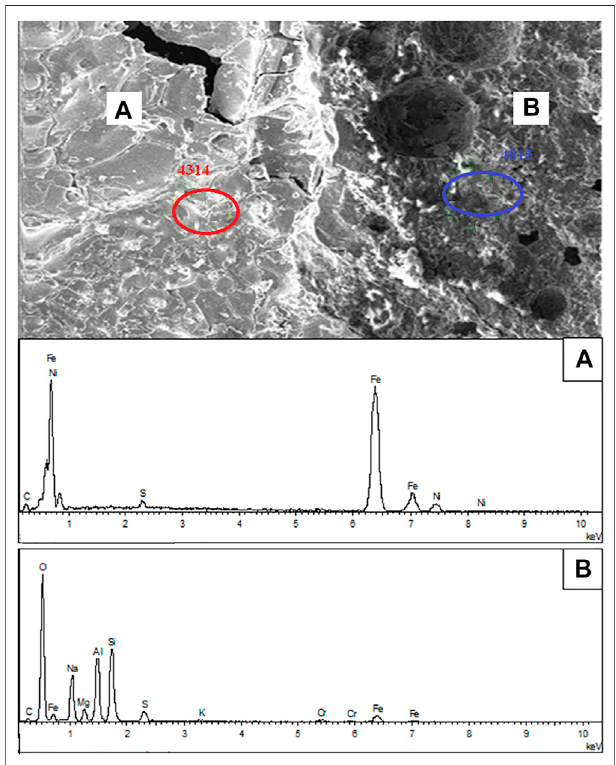
FIGURE 10 | SEM-EDS analysis of the calcined product of laterite/ Na 2 S 2 O 3 blends: (A) bright area and (B) gray